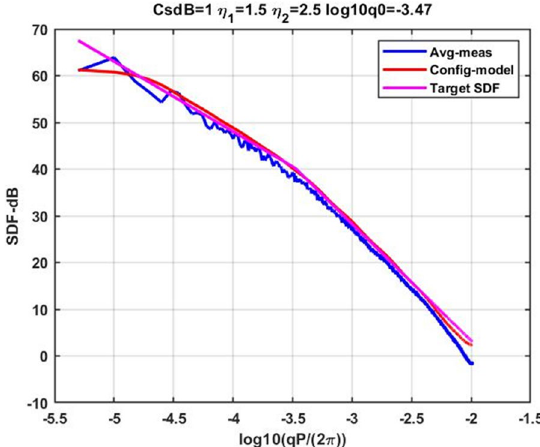
Fig. 8 One-dimensional SDF derived from configuration-space realization (blue), with target SDF (red) and configuration theoretical SDF (magenta)